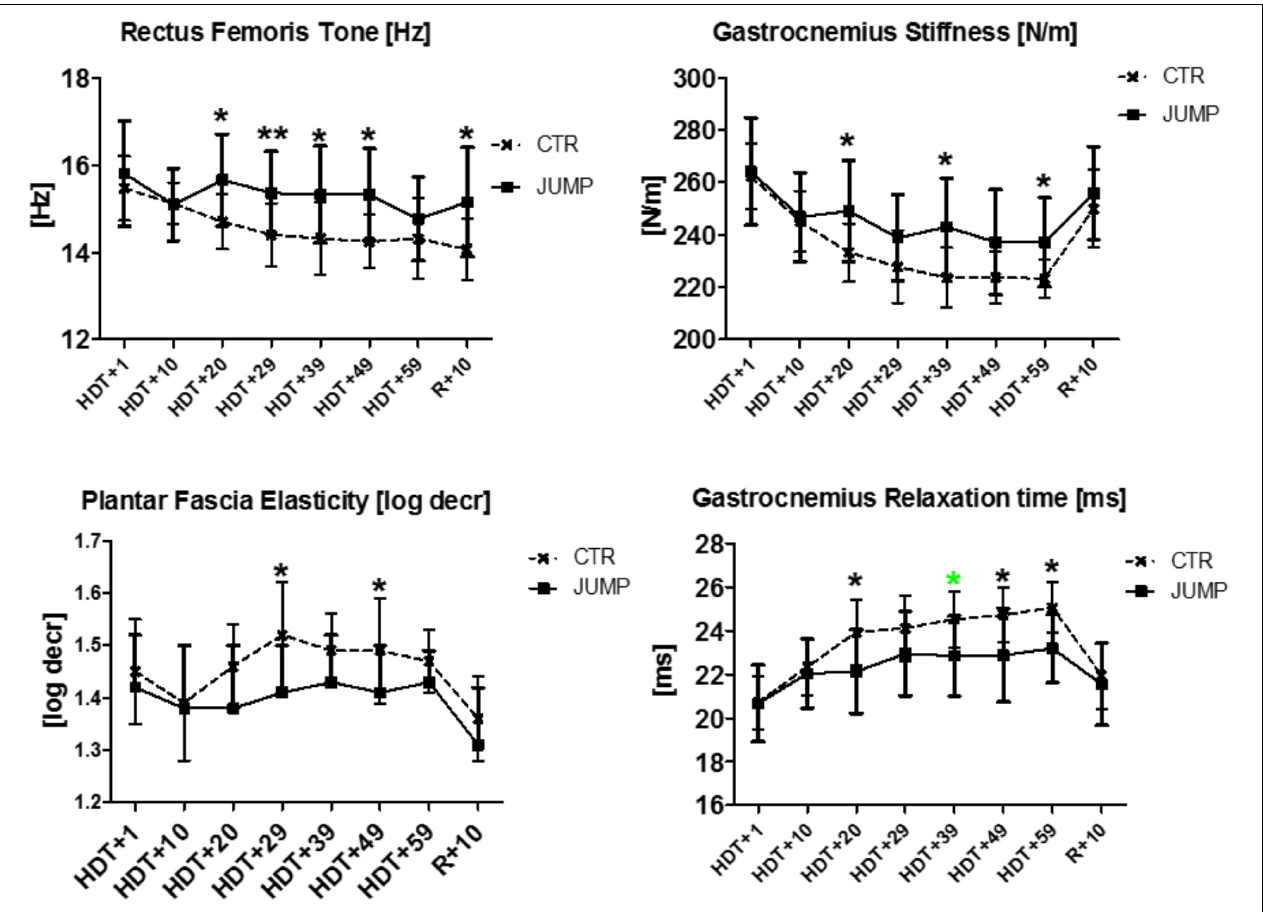
FIGURE 12 | Biomechanical and viscoelastic property changes at different time intervals during RSL bed rest. First changes between groups are detectable in Rectus femoris [tone, Hz], Gastrocnemius (stiffness [N/m], relaxation time [ms]) from HDT+20 onwards (3rd week in bed rest), as well as in Plantar fascia (elasticity, log decrement), from HDT+29 onwards (4th week in bed rest). Mann–Whitney- U test, Spearman ρ , ∗ p < 0.05, ∗∗ p <